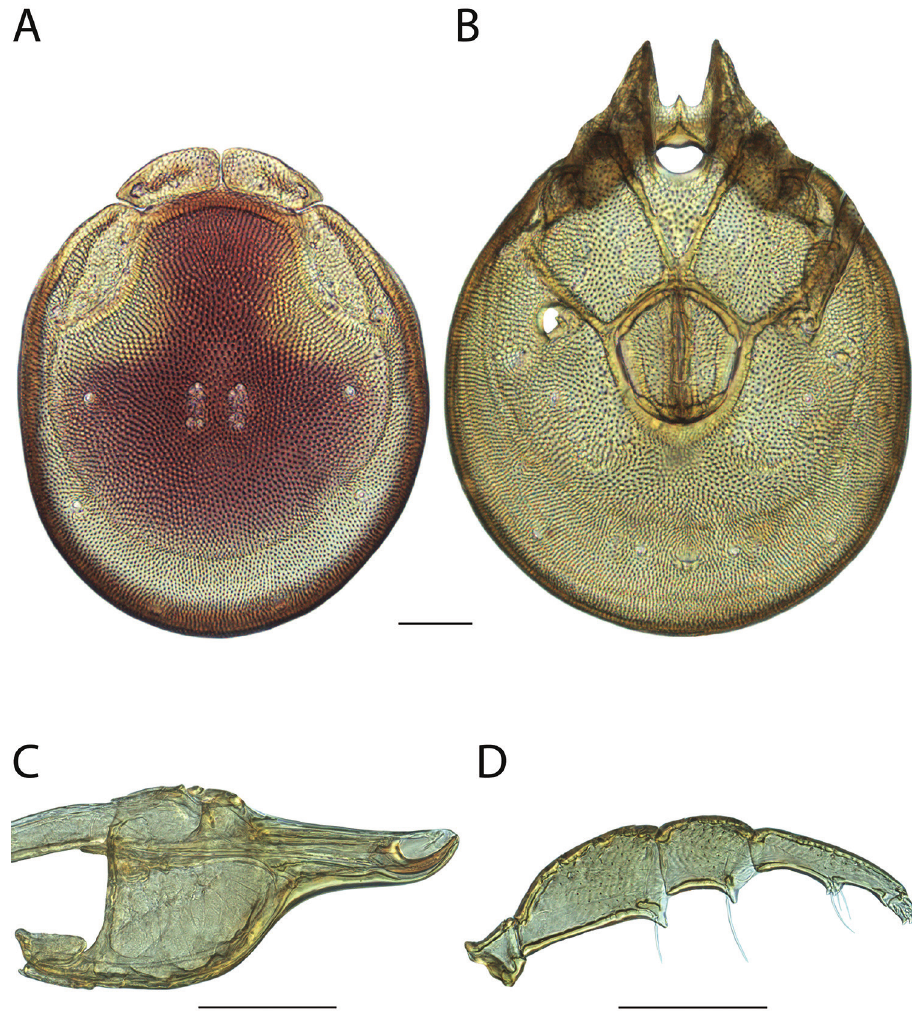
Figure 197. Torrenticola priapus sp. n. female: A dorsal plates B venter (legs removed) C subcapitulum D pedipalp (setae not accurately depicted). Scale = 100